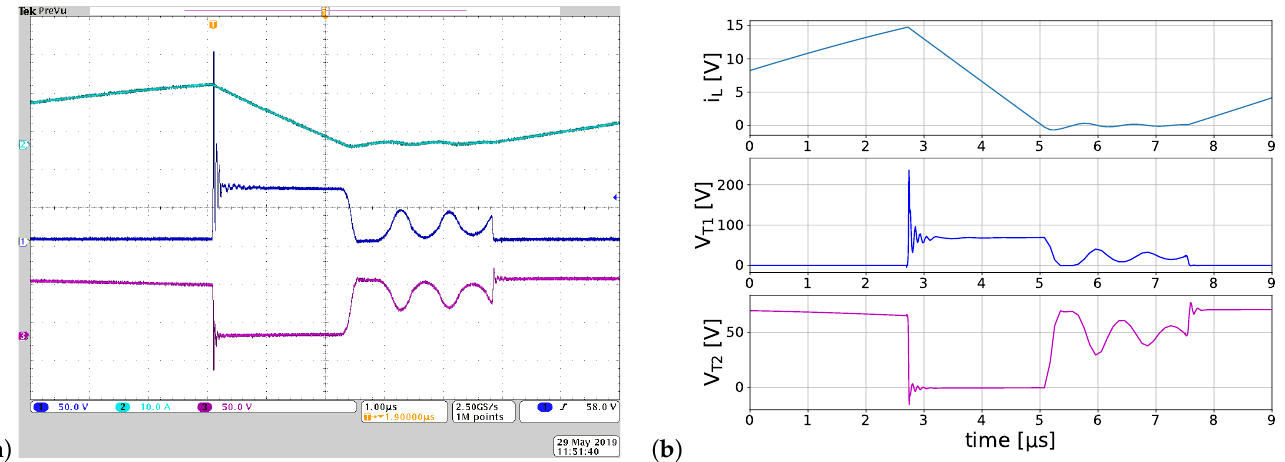
Figure 10. The buck converter at DCM operation ( i L , V T 1 and V T 2 ): ( a ) experiment (time: 1 µ s/div, i L : 10 A/div, V T 1 , V T 2 : 50 V/div) and ( b )